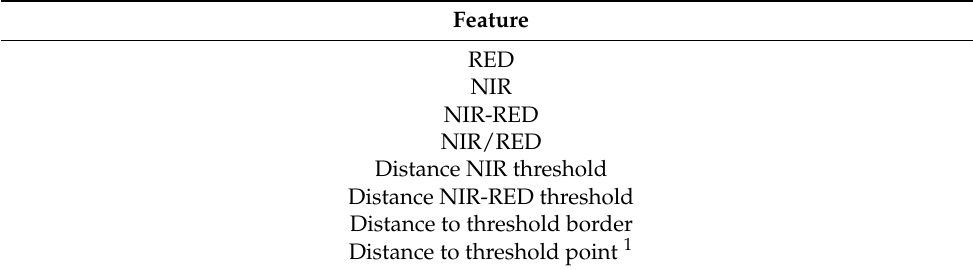
Table 1. Input features for the linear mixture